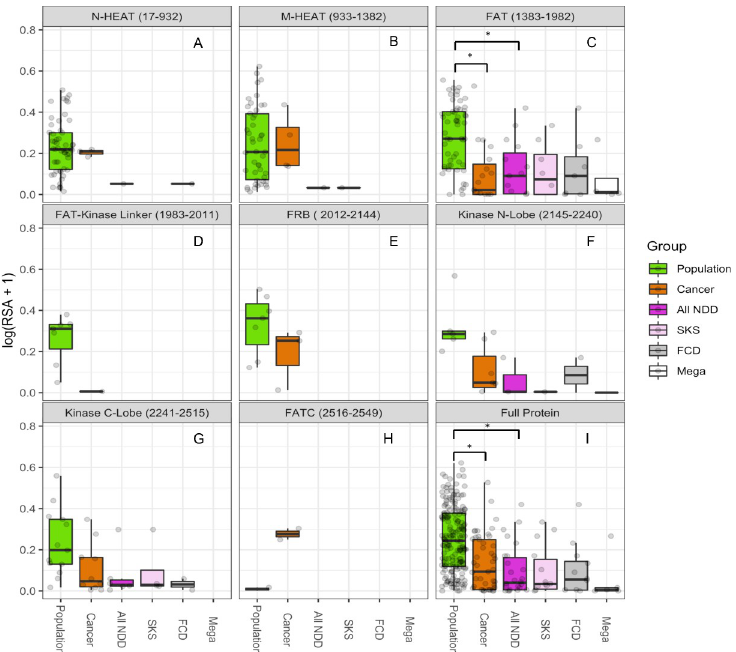
Fig 4. Disease-associated MTOR Variants Have Lower Relative Accessible Surface Area Than Proximal Population Variants Based on Domain Location. (A-B) and (D-H) relative accessible surface area (RSA) of MTOR variants is not significantly different between groups for these domains. (C) There is significantly lower ( � , p < 0.01, Pairwise Wilcoxon Rank Sum Test with Bonferroni correction) RSA in disease-associated MTOR variants within the focal adhesion targeting (FAT) domain and (I), across the full protein. The gray panel headings contain protein domain name with residue range in brackets. SKS, FCD, and Mega are subgroups within the “All Neurodevelopmental Disorder” (NDD) group. SKS = Smith-Kingsmore syndrome; FCD = focal cortical dysplasia; Mega =